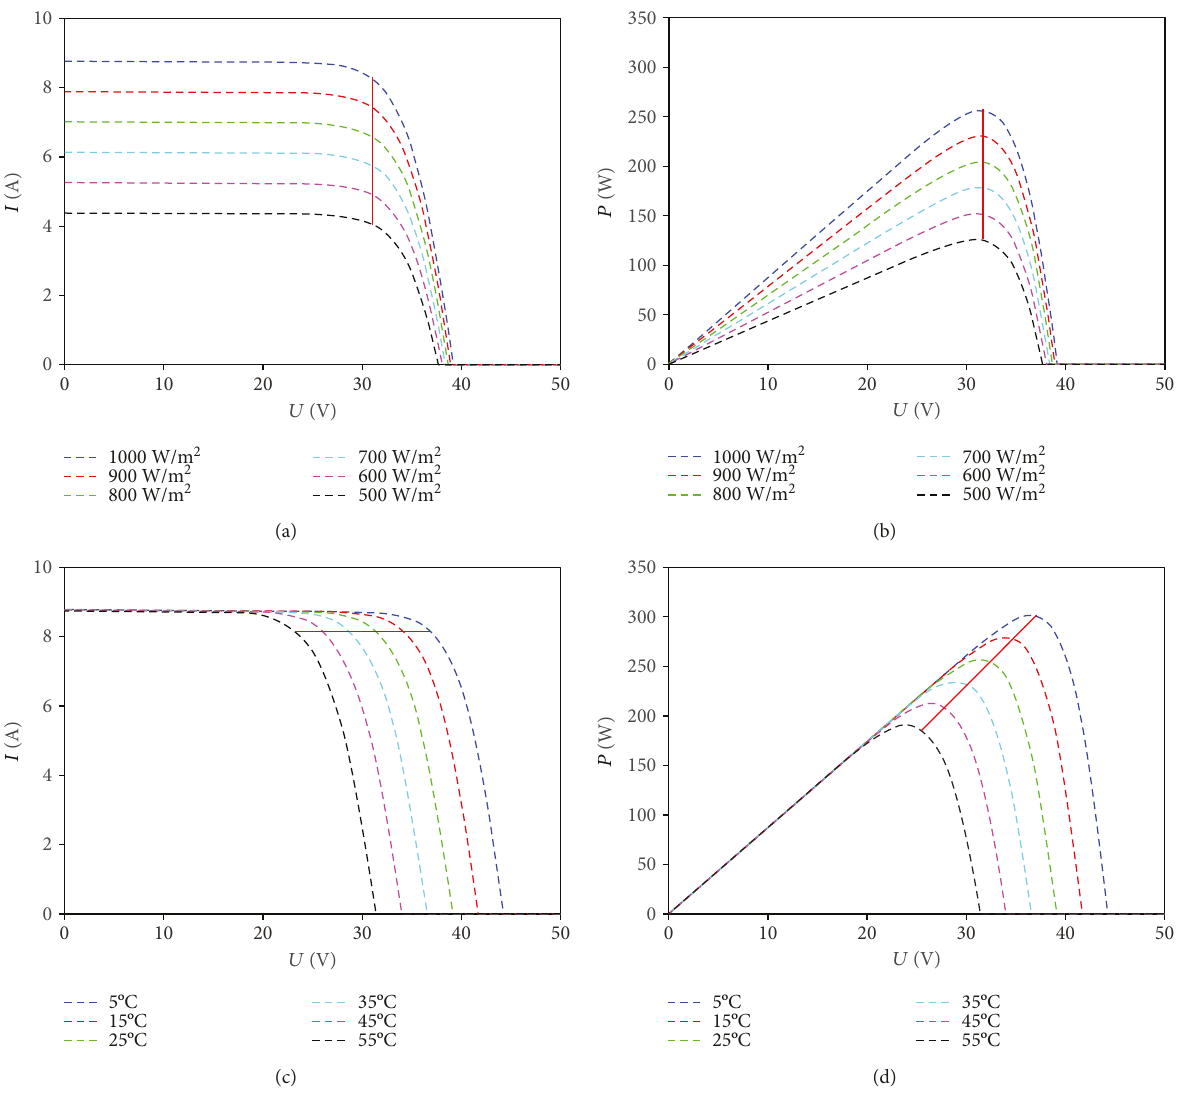
Figure 6: (a) IV curve under di ff erent irradiances, (b) PV curve under di ff erent irradiances, (c) IV curve under di ff erent temperatures, (d) PV curve under di ff erent temperatures. Describing the IV and PV curves under di ff erent operating